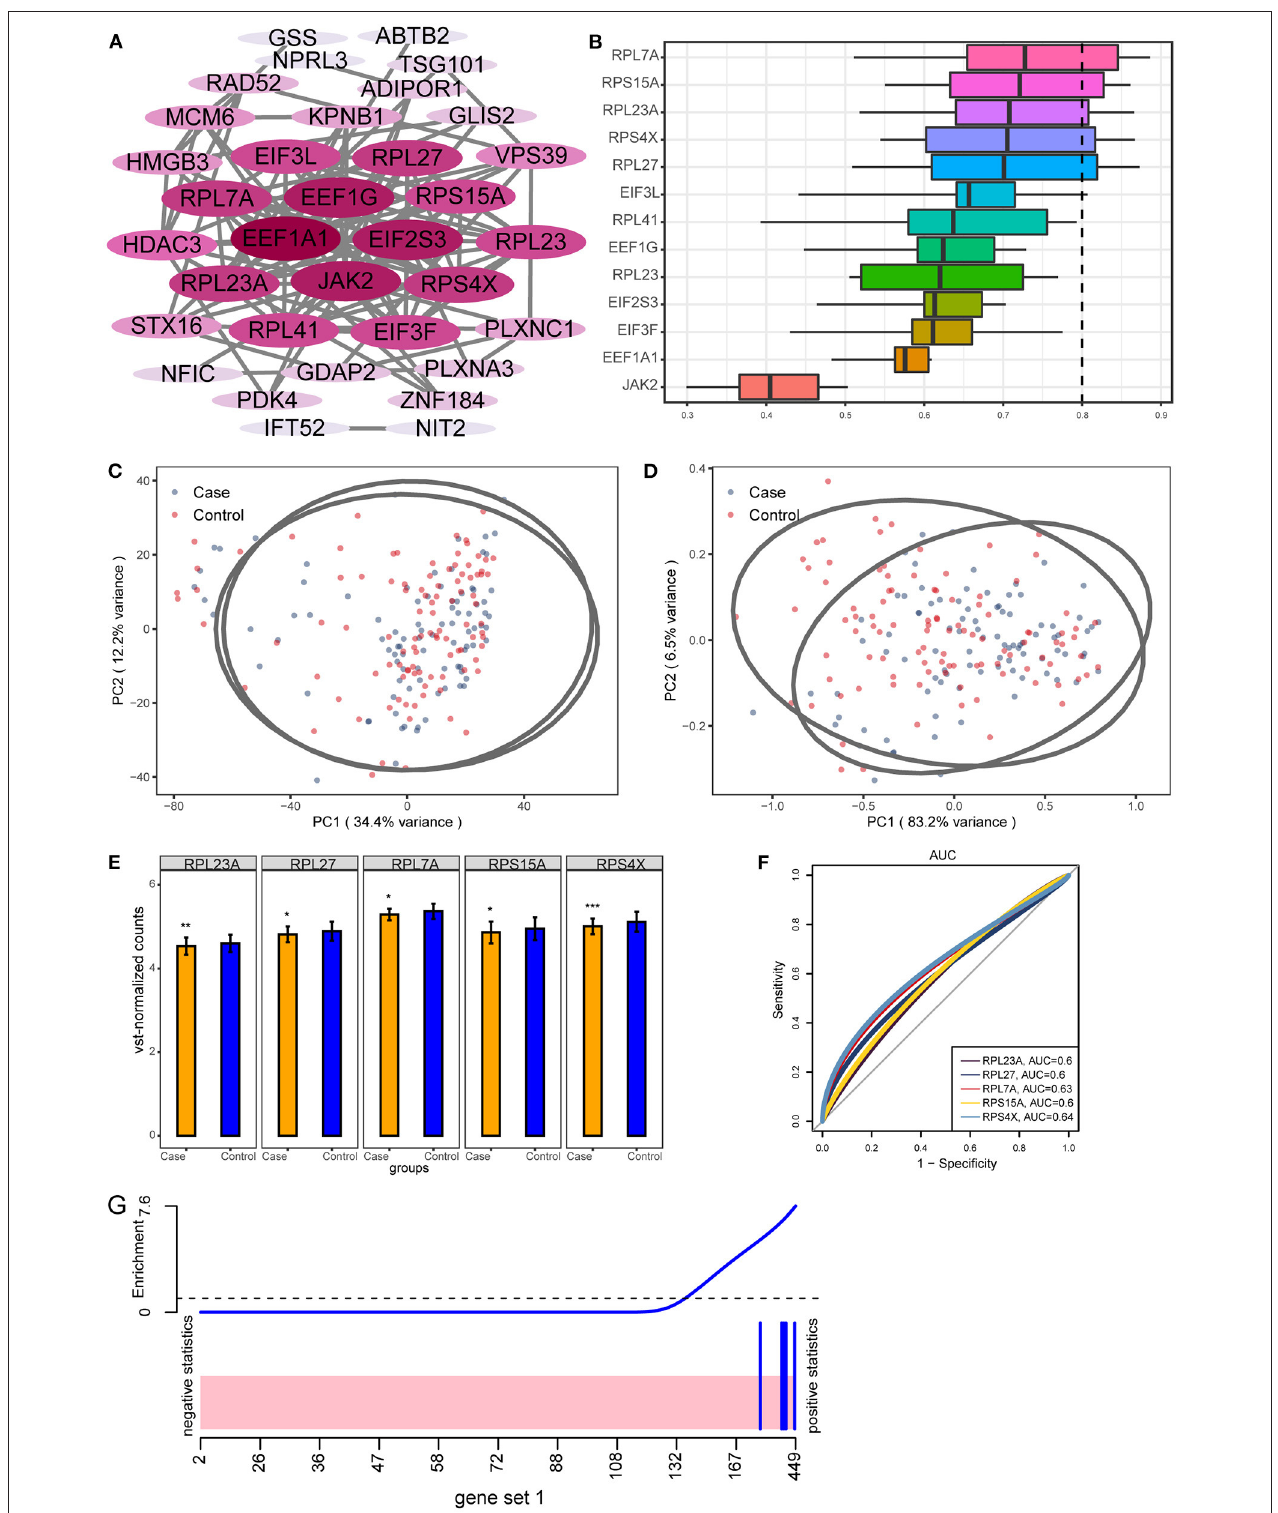
FIGURE 4 | Key genes with potential diagnostic role for TBI. (A) The PPI network of 50 genes with larger AUC values. The darker the color, the more connected the gene is in the network. (B) GO functional similarity of the top 10 genes with the greatest connectivity. (C) Primary component analysis of TBI and control in GSE104687. (D) Distinguishing TBI and control samples in GSE104687 using hub genes expression. (E) The differential expression of hub genes between TBI and control in GSE104687. * P < 0.05, ** P < 0.01, *** P < 0.001. (F) The AUC values of hub genes. (G) Gene set analysis barcode plot. The differential gene expression in hub genes is shown as a shaded rectangle; genes up-regulated are shaded pink.